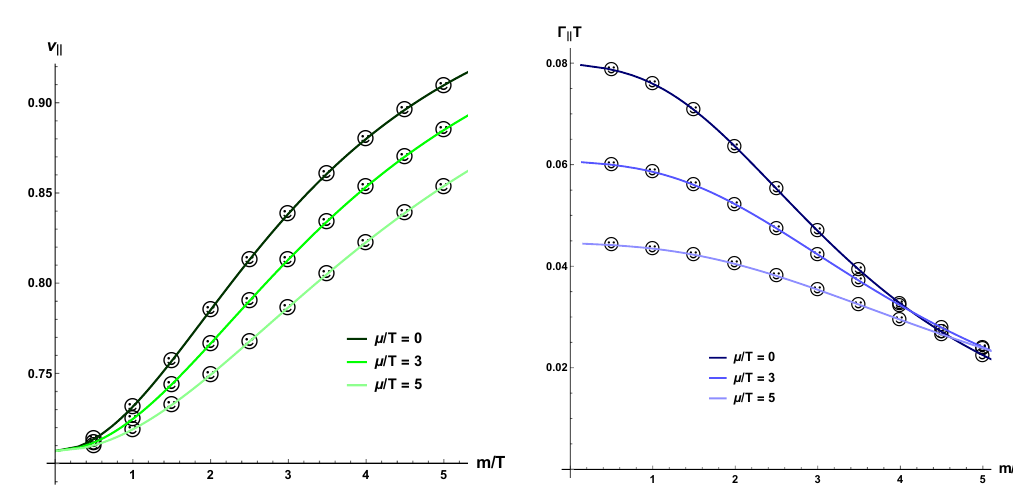
Figure 7 . The predictions from hydrodynamics for the benchmark potential V ( X ) = m 2 X 3 and various values of (cid:22)=T . Left: The speed of longitudinal sound. Right: The longitudinal sound attenuation constant.